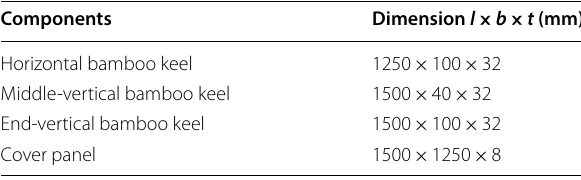
The l is length, the b is width and the t is thickness